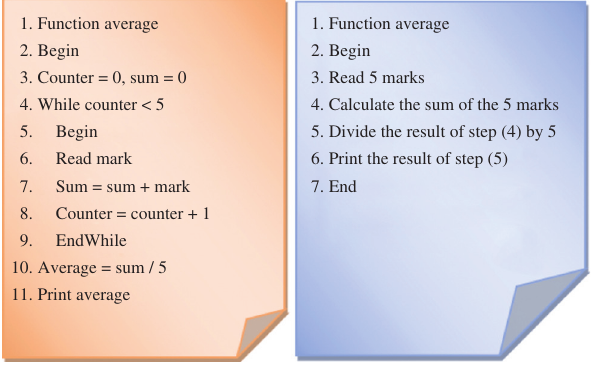
Figure 2: Two Different Pseudocodes for a Given